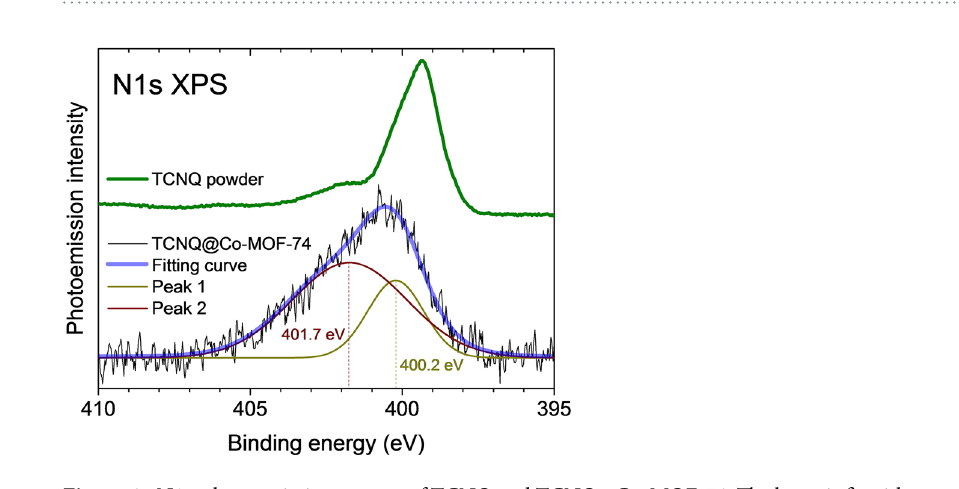
Figure 4. N1 s photoemission spectra of TCNQ and TCNQ@Co-MOF-74. The latter is fit with two gaussian